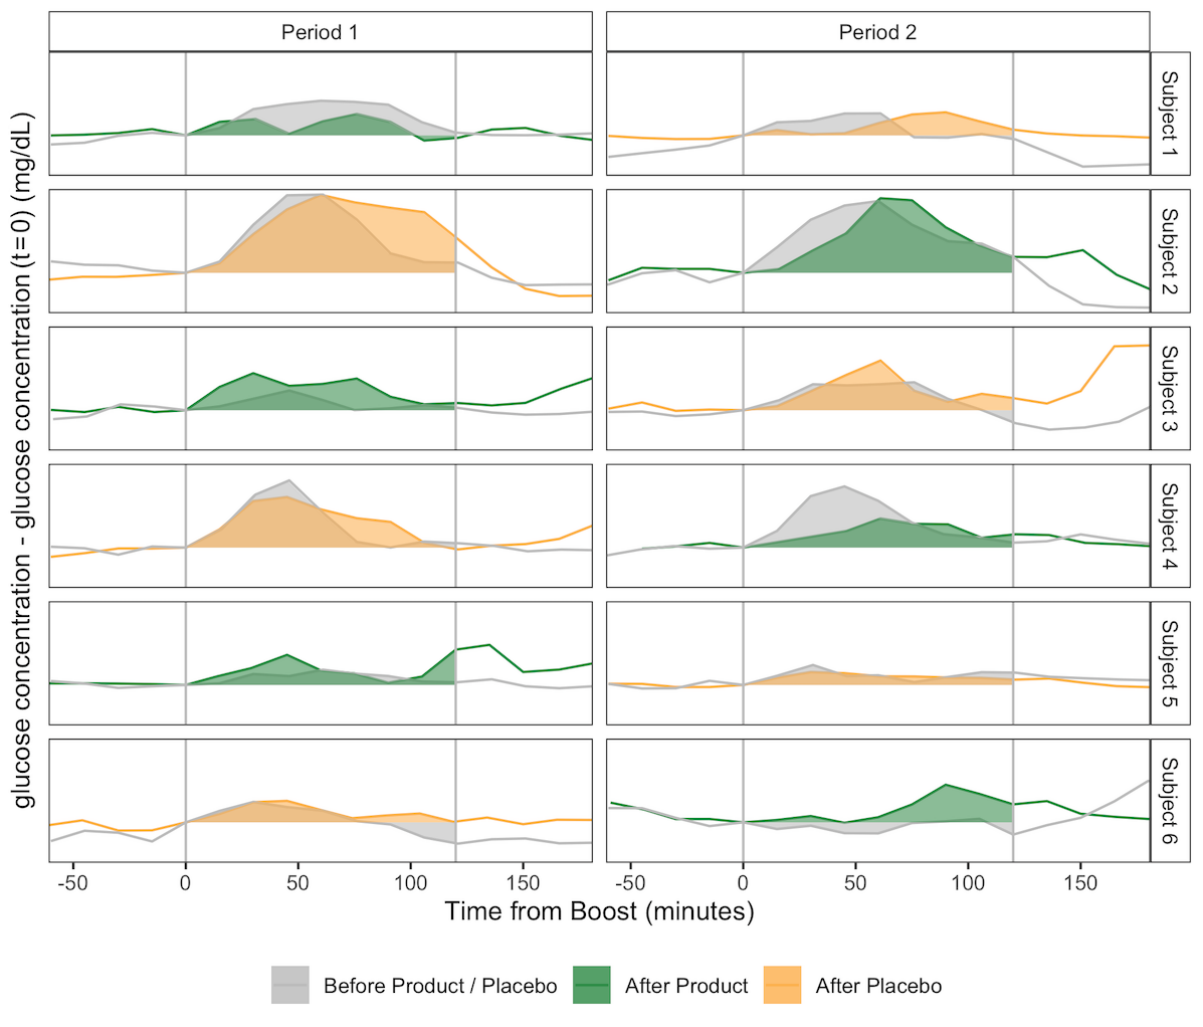
Figure 2. Results of the meal tolerance test (MTT). Glucose response to standardized meals for all six subjects in the study. Area under the curve values for the beginning of placebo/product, end of placebo, and end of product periods are in gray, yellow, and green, respectively. The MTTs are annotated